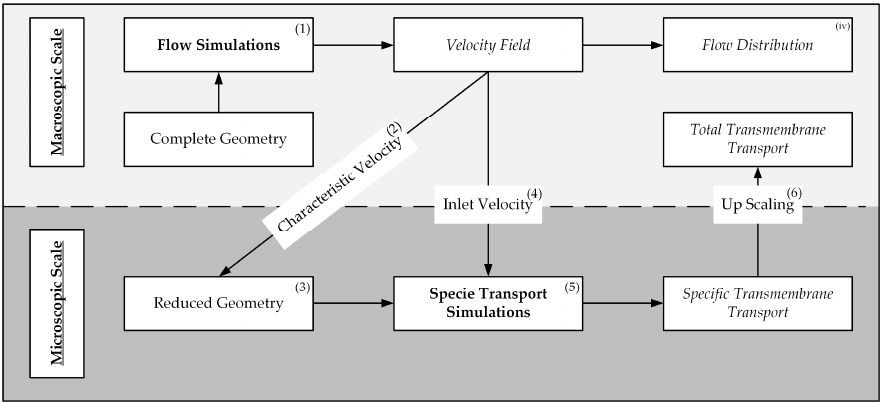
Figure 5. Workflow of the upscaling method for CFD based prediction of oxygenator CO 2 removal performance—by Lukitsch et al. [16] (CC BY